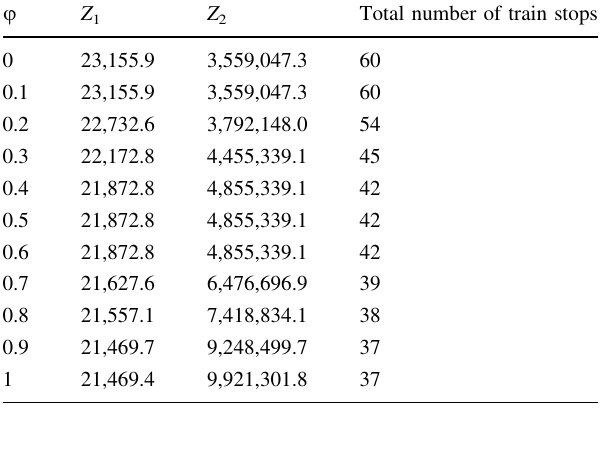
Table 10 Sensitivity analysis of the u parameter